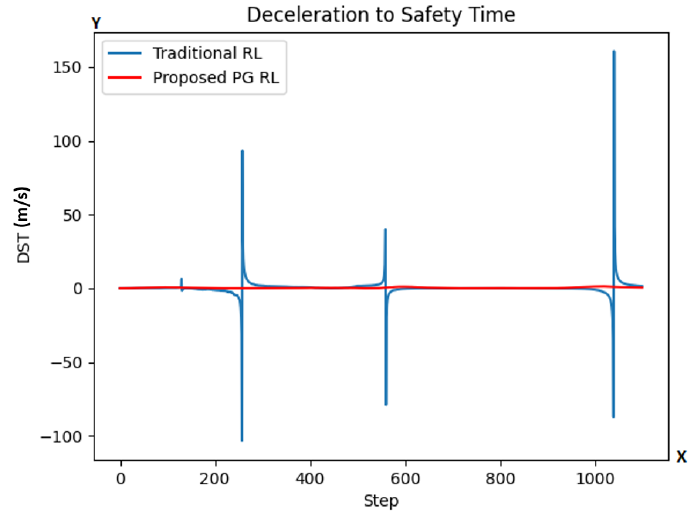
Figure 8. DST values at each step for both models (traditional RL in blue color line; our proposed PG RL model in red color line). The y -axis is representing the DST while the x -axis represents the number of simulation steps.